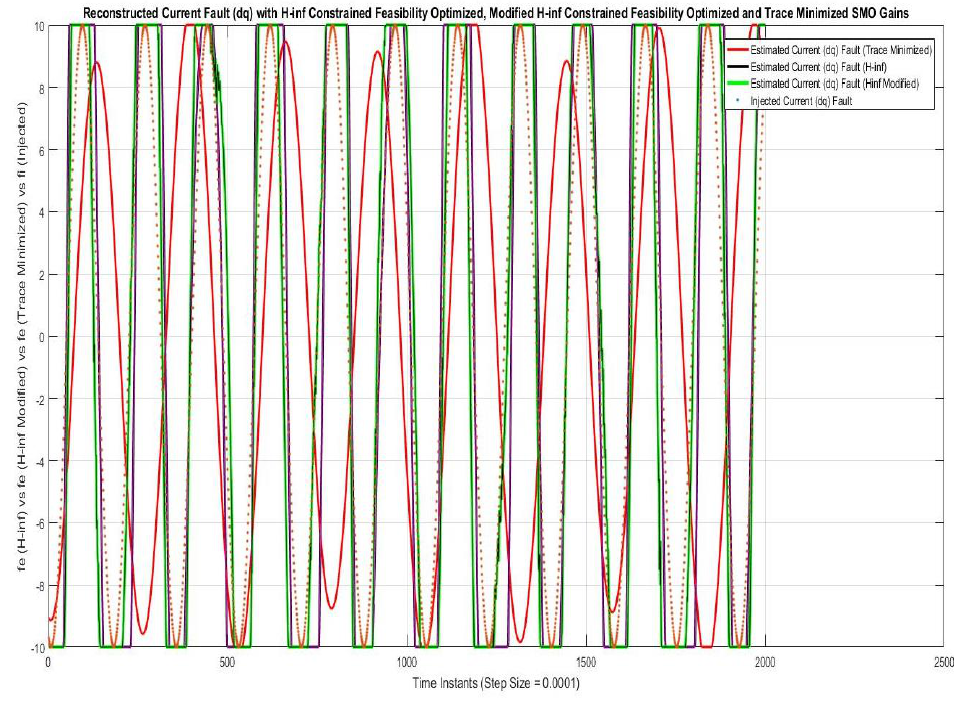
Figure 9. Current (dq) fault